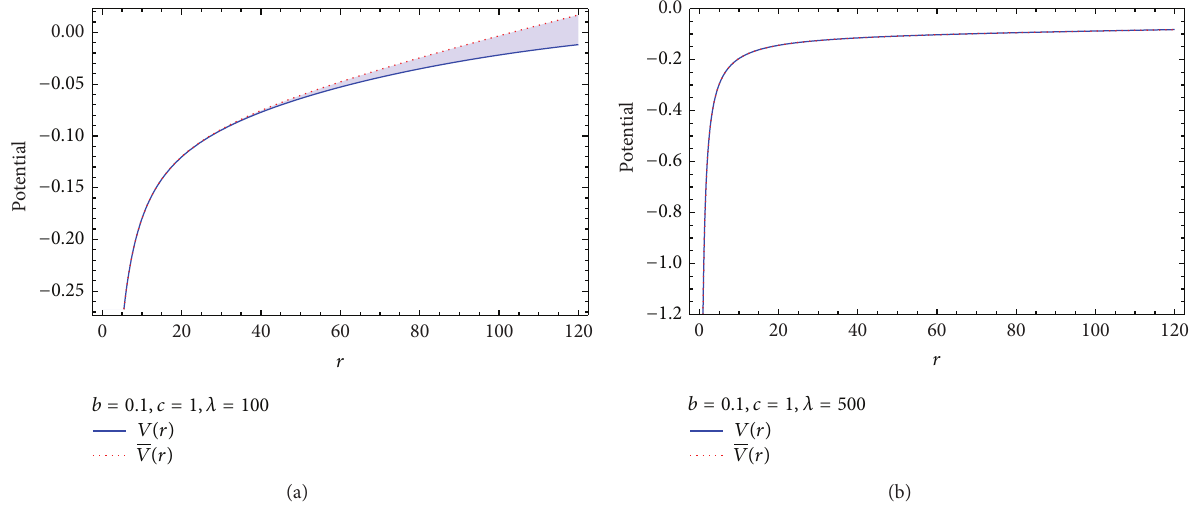
Figure 5: (a) Comparison of 𝑉(𝑟) and 𝑉(𝑟) potentials in case of 𝑏 = 0.1 , 𝑐 = 1 , and 𝜆 = 100 (in arbitrary units). (b) Comparison of 𝑉(𝑟) and 𝑉(𝑟) potentials in case of 𝑏 = 0.1 , 𝑐 = 1 , and 𝜆 = 500 (in arbitrary units).